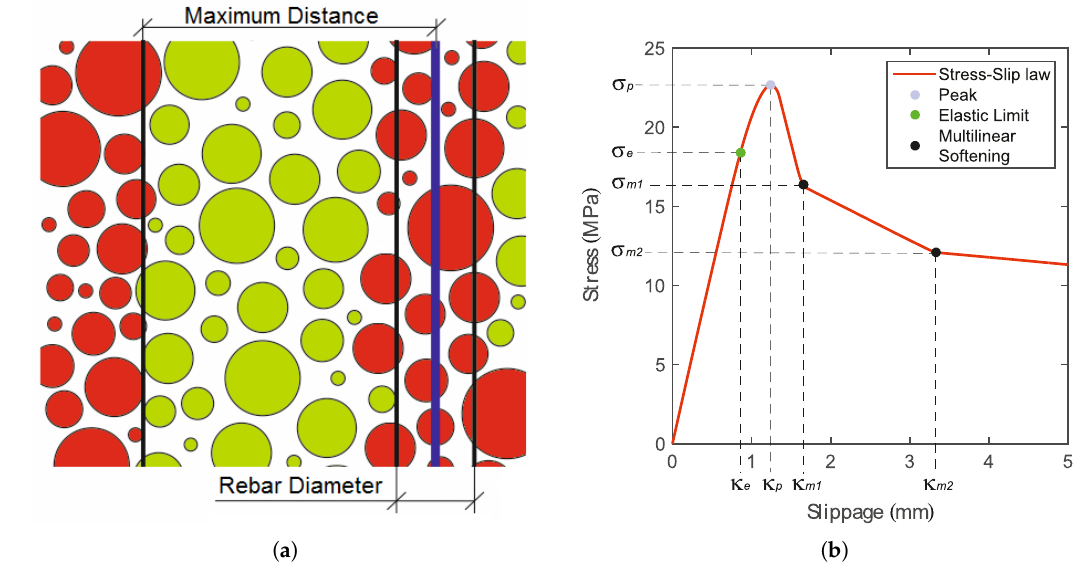
Figure 3. ( a ) 2D representation of threaded bar (blue), potential lattice discrete particle model (LDPM) particles connected with it (green) and non-connected particles (red); and ( b ) stress-slip law